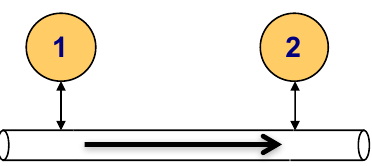
Figure 7: Schematic showing the basic setup of a cascaded quantum system, where two quantum systems interact via a unidirectional (i.e. “chiral") waveguide. In the Markovian limit, the interactions mediated between the two systems via the waveg- uide correspond exactly to our effective directional Lindblad master